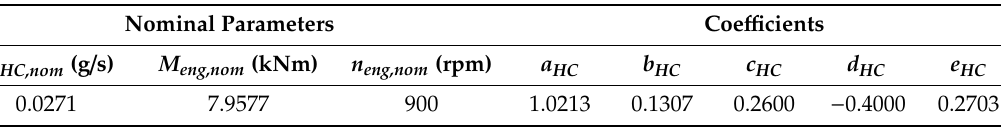
Table A5. Coefficients of HC emission model of auxiliary engine.